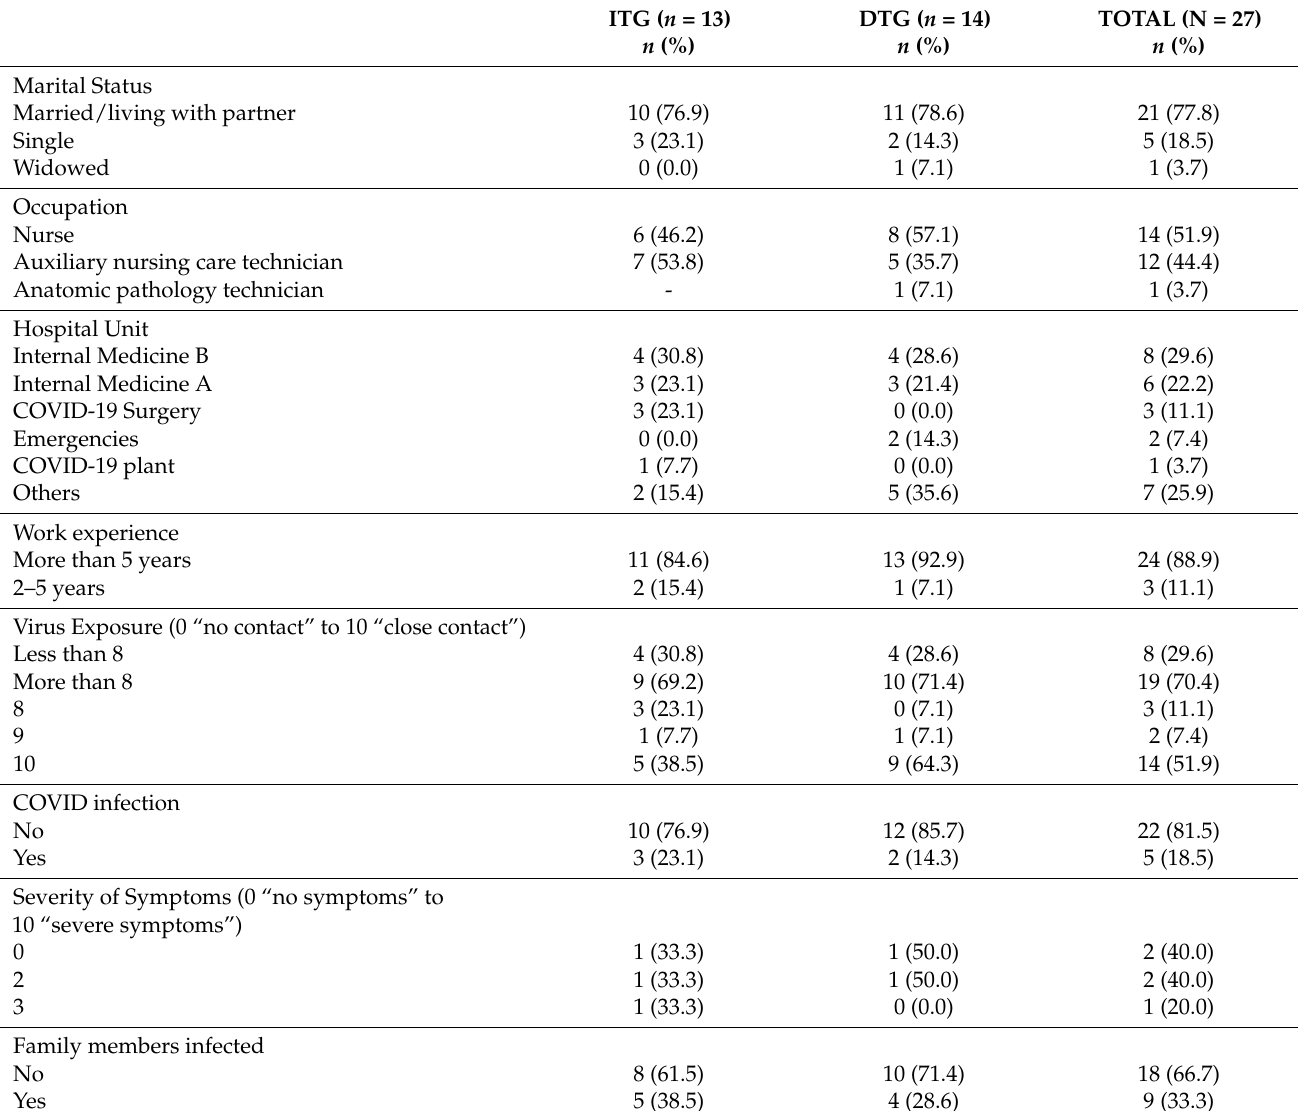
Table 1. Baseline socio-demographic characteristics of the sample across treatment conditions (N =